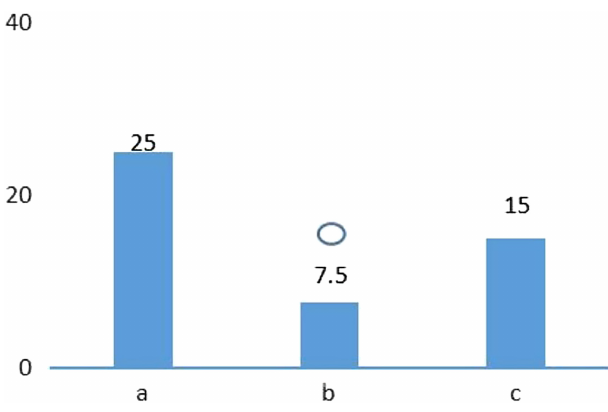
Figure 2. Comparison of adverse effects of the 3 groups. (A) Traditional quadruple therapy group; (B) vonoprazan triple therapy group; (C) vonoprazan quadruple therapy